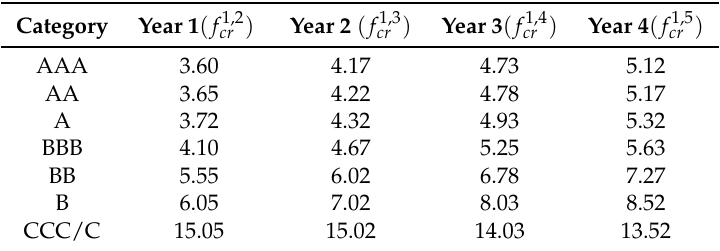
Table 2. One-year forward zero curve for each credit rating category ( % ) . Adapted from [4] with permission from